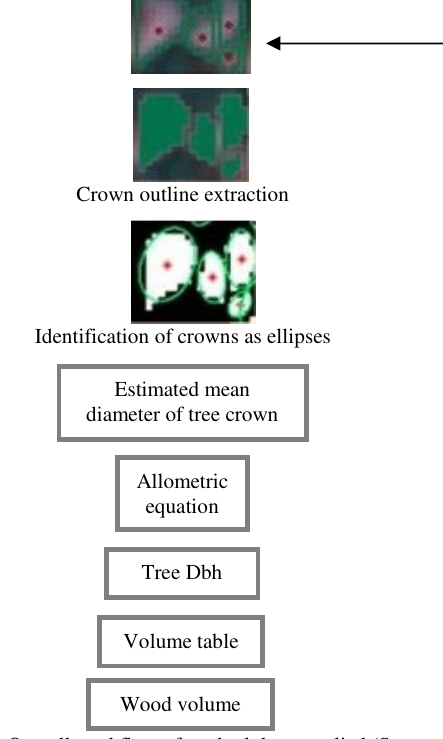
Figure 5. Overall workflow of methodology applied (Stournara,